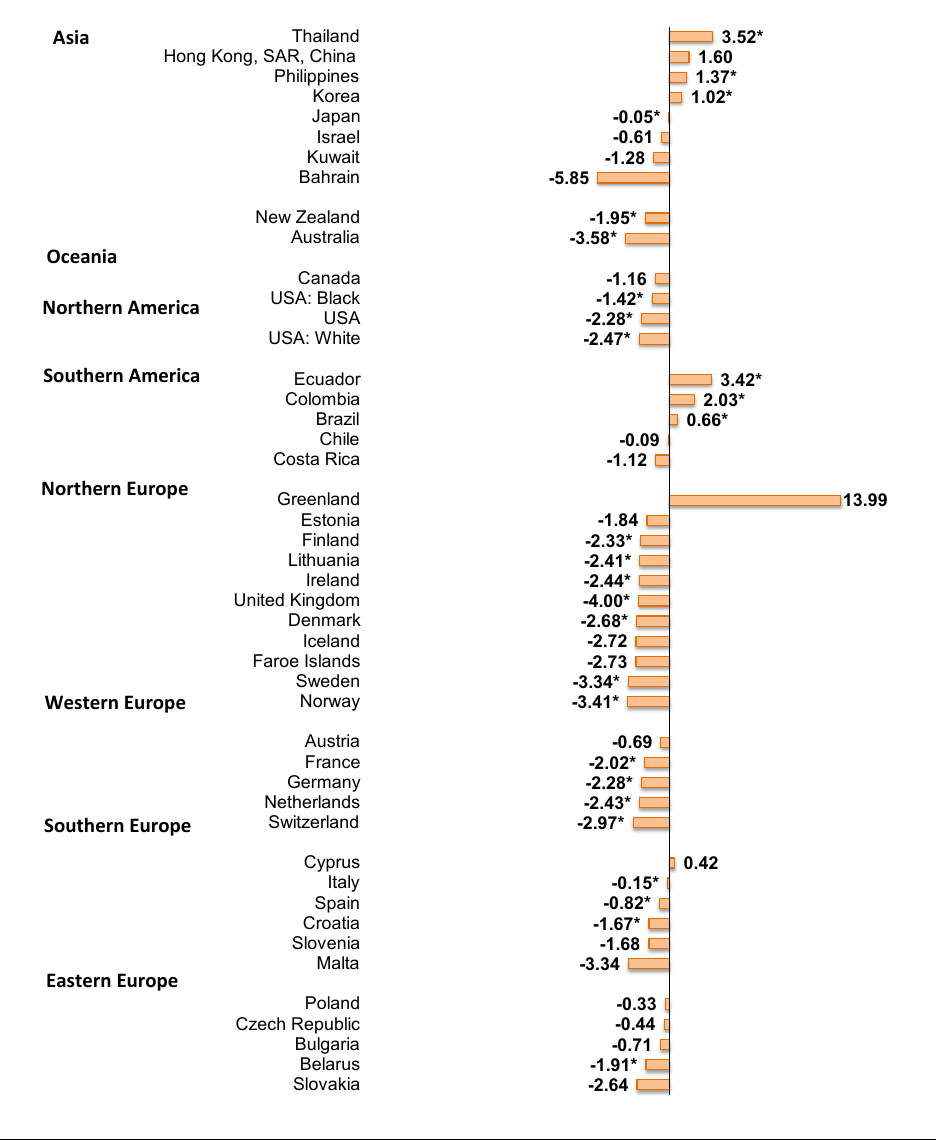
In the 48 countries, 21 showed a decrease in incidence of ovarian cancer (Figure S3), with Brazil having highest decline in incidence (AAPC = − 4.02, 95% C.I. − 6.56 to − 1.41, p = 0.008), followed by Slovenia (AAPC = − 3.86, 95% C.I. − 6.51 to − 1.14, p = 0.012), the United States (AAPC = − 3.01, 95% C.I. − 4.23 to − 2.22, p < 0.001), Switzerland (AAPC = − 2.93, 95% C.I. − 5.36 to − 0.44, p = 0.027), and Austria (AAPC = − 2.60, 95% C.I. − 3.41 to − 1.78, p < 0.001). On the contrary, only two countries had an increase in the incidence of ovarian cancer, including Japan (AAPC = 2.35, 95% C.I. 1.15 to 3.55, p = 0.002), and Belarus (AAPC = 1.88, 95% C.I. 1.21 to 2.54, p <